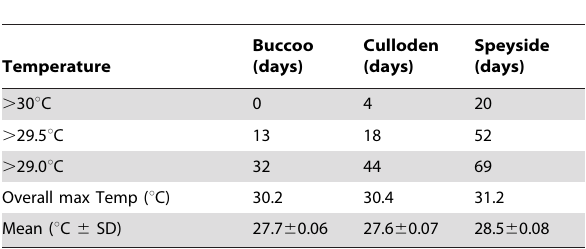
Table 1. Profile of extreme in situ temperatures experienced at Buccoo, Culloden and Speyside over the period October 2010 to March 2011 during the 2010 mass bleaching